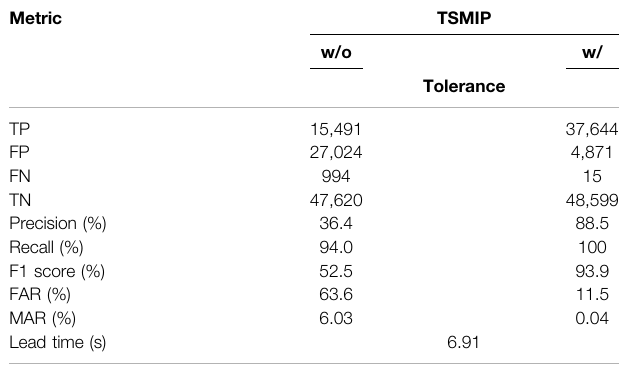
TABLE 5 | The performance metrics of the TSMIP data set using the proposed LSTM model with an alternative alert criterion. Metric